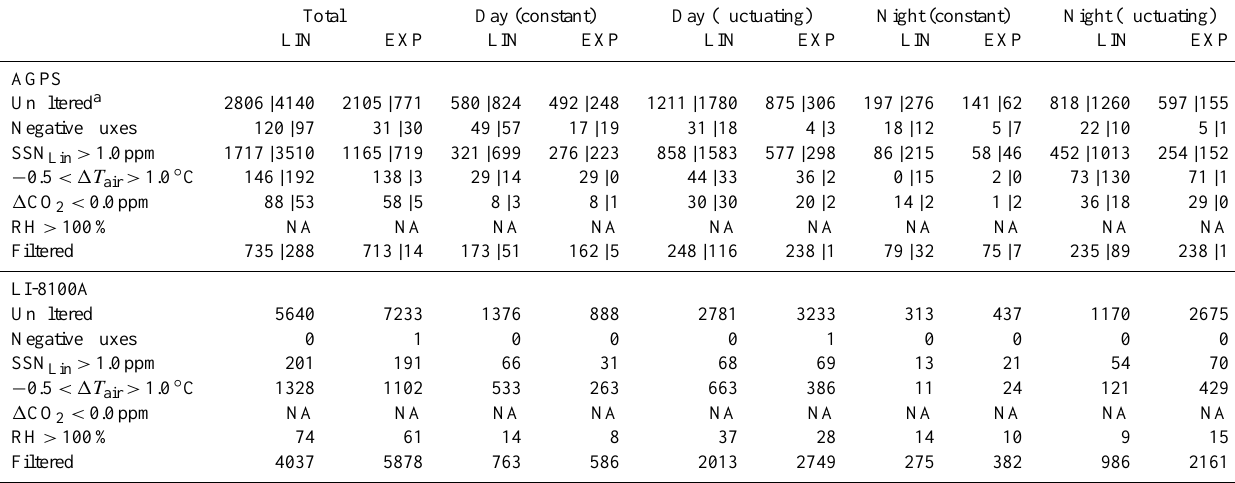
Table 2. Number of discarded CO 2 fluxes after each filter step for the two automated chamber systems (SSN Lin is the normalised sum of squares of residuals for linear fit; (cid:49)T air is the change in air temperature inside the closed chamber during the closure time; (cid:49) CO 2 is the difference in the atmospheric CO 2 concentration 5cm above the collar directly before chamber closure and after a deadband of 1min; RH is relative humidity; NA indicates information not available for that chamber system). Data sets were grouped by time of the day and stability of the atmospheric CO 2 concentration at 50cm above the soil surface. Day and night were based on sunrise and sunset times. Atmospheric CO 2 concentration was considered as constant when the standard deviation for a 3min measurement prior to the chamber closures was ≤ 1.0ppm. The AGPS total closure time was 10min. Fluxes were once calculated for the first 4min of the closure time (left of the vertical line) and once for 9min closure time (right of the vertical line), each with a 1min